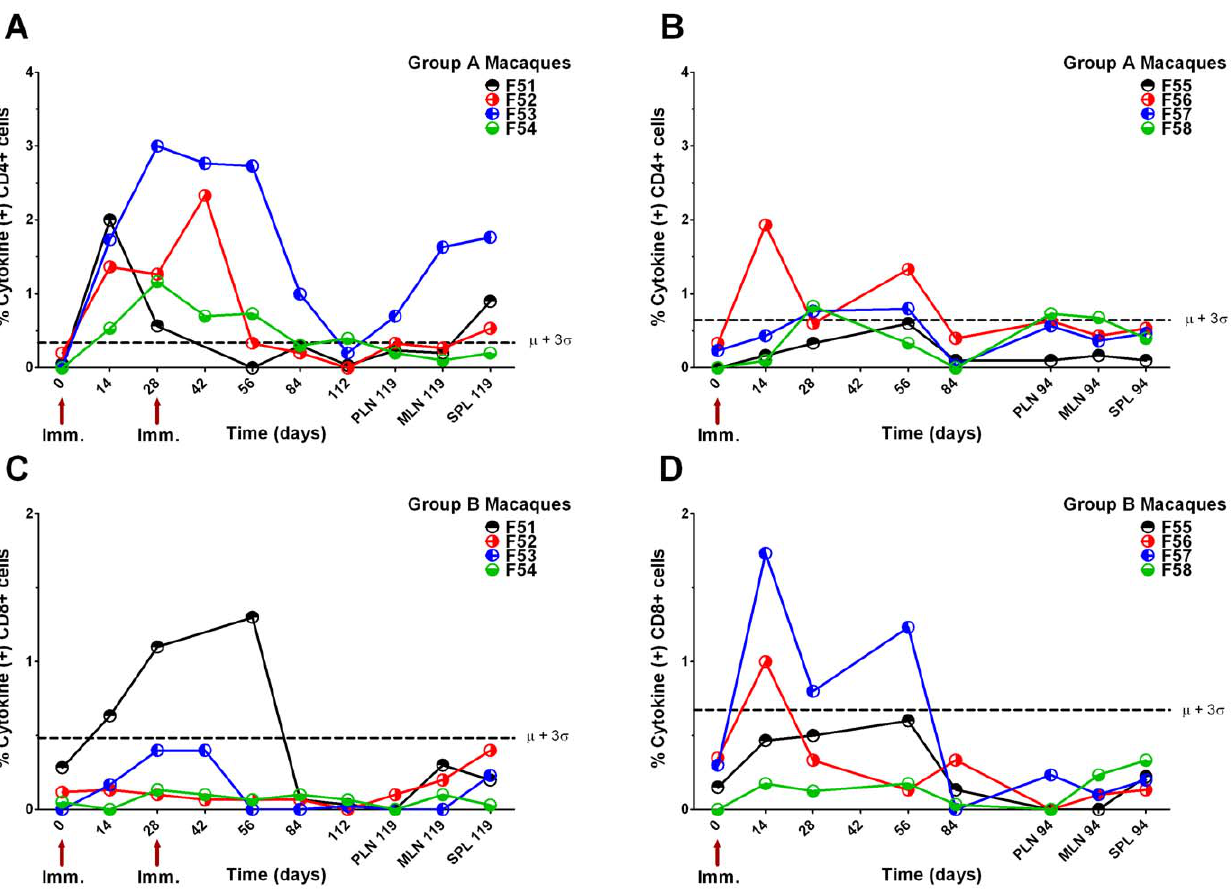
Figure 6. Macaque T cell cytokine responses to empty MV. Total cytokine (sum of TNF a + , IL-2 + and IFN c + cells) response to MV by CD4 + and CD8 + T cells from peripheral blood (PBMCs), peripheral lymph nodes (PLN), mesenteric lymph nodes (MLN) and spleen (SPL). Time in days is shown on x-axis, all responses from PBMC unless prefixed by a tissue. Group A, macaques F51–F54, were immunised with 10 5 TCID 50 MV1-F4 on days 0 and 28 whilst group B, macaques F55–F58, were immunised on day 0 only. Panels A and B shows cytokine responses gated on CD4 + T cells. Panels C and D show cytokine responses gated on CD8 + T cell. Dashed line represents the mean plus 3 standard deviations of day 0 responses, above which points were deemed significant.